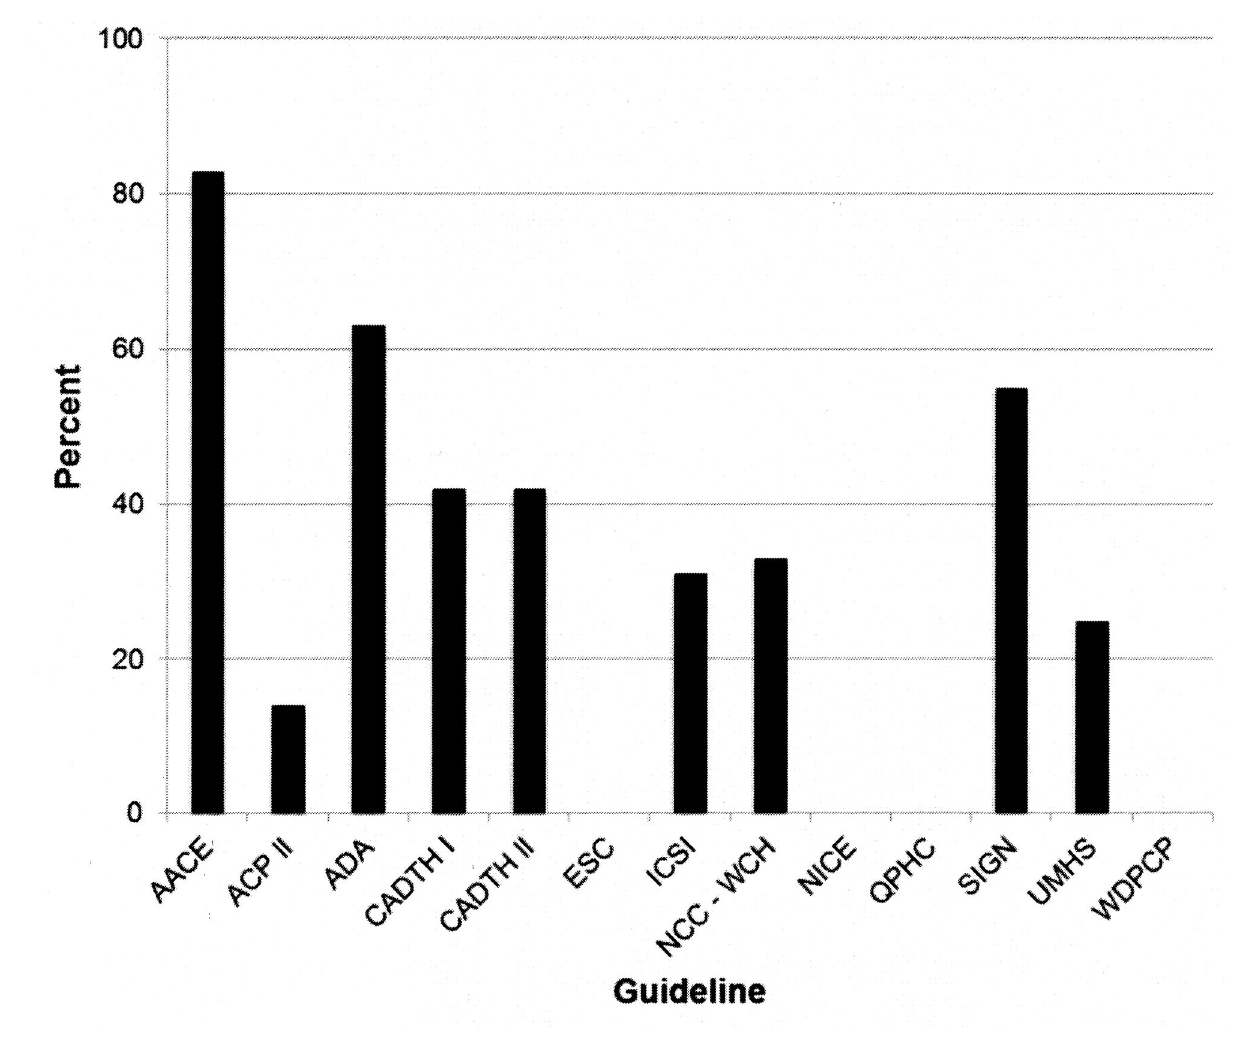
Figure 1. Guideline authors with financial interests in recommended drugs. Percentage of authors of clinical practice guidelines with a financial interest in one or more of the manufacturers of patented drugs recommended in each guideline. Abbreviations. See list for Table